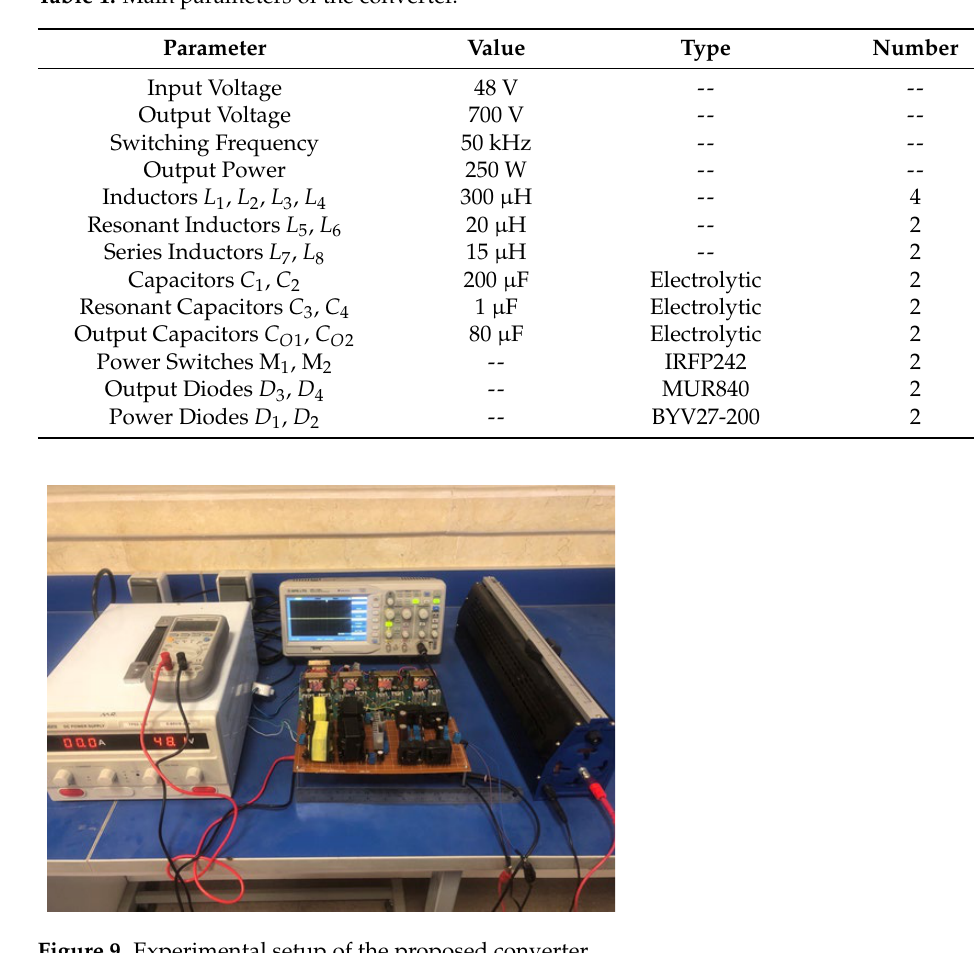
Figure 8. Simulation waveforms of the proposed converter: ( a ) voltage and current of switch M 1 , ( b ) voltage and current of diode D 4 , ( c ) voltage and current of diode D 2 , ( d ) voltage of capacitors C 3 and C 4 , ( e ) current of inductors L 5 and L 6 , and ( f ) current of inductors L 7 and L 8 . Table 1. Main parameters of the converter.